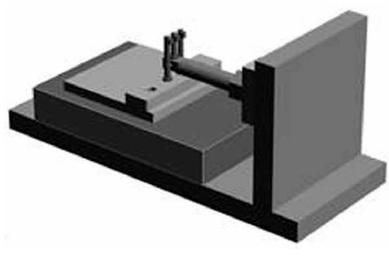
Figure 8. Three-point bending systems.